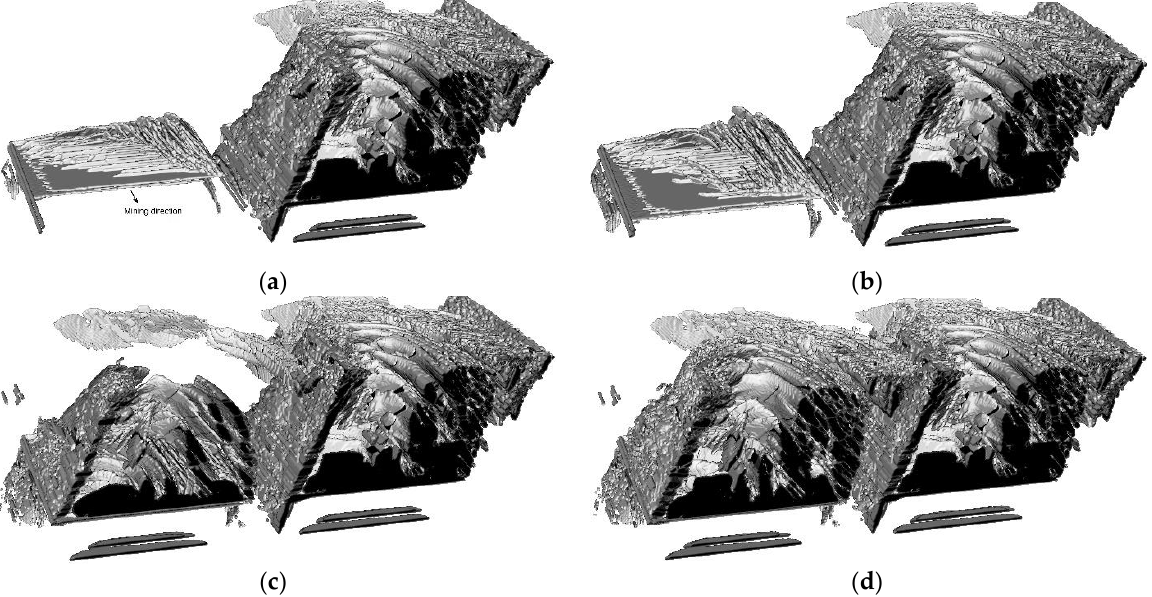
Figure 7. Stages of damage development in the course of the gob increase in panel 2: ( a ) 136 m, ( b ) 178 m, ( c ) 203 m, and ( d ) surface subsidence state. ( b ) 178 m, ( c ) 203 m, and ( d ) surface subsidence